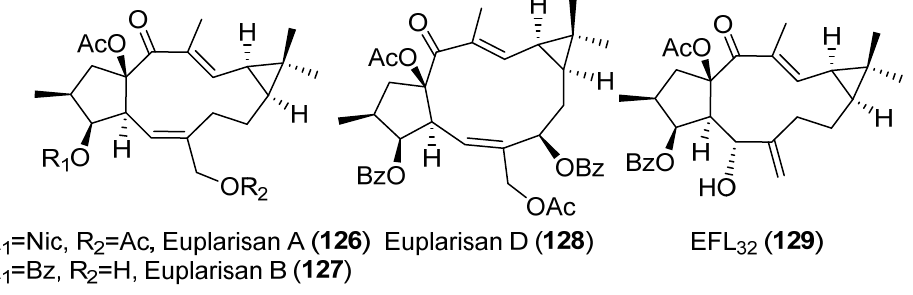
Figure 21. Structure of compounds 126 – 129